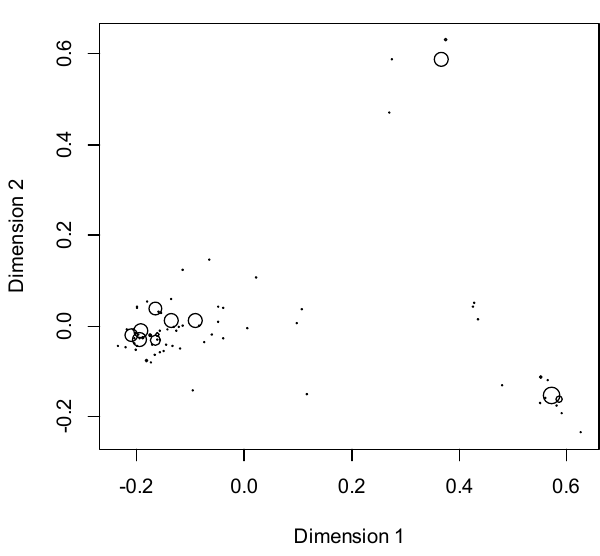
Figure 7. ‘not...until’ and word order.